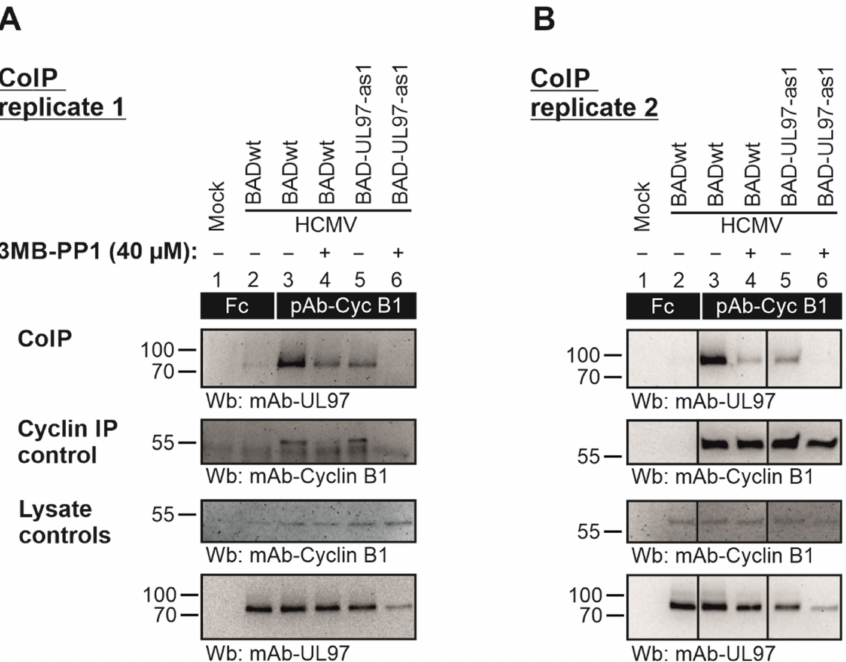
Figure 7. HFFs were cultivated in T175 flasks and used for infection with parental HCMV BADwt or recombinant BAD-UL97-as1 at a MOI of 0.5 for 4 d. An optional treatment with 40 µ M of 3MB-PP1 (+, 3MB-PP1; − , DMSO solvent controls) was performed starting 4 h prior to sample collection and again during cell lysis. Total cell lysates were prepared and used for cyclin B1-specific CoIP with the indicated antibodies (see black boxes; Fc fragment was used as a negative control) under the continuous presence of 3MB. ( A , B ) show two independently produced biological replicates of this CoIP experiment, in order to illustrate the range of variability of individual signal strengths of detected protein bands. The CoIP samples were subjected to SDS-PAGE/Wb analysis (CoIP) and additional control stainings were performed to verify successful immunoprecipitation (cyclin IP control) and protein expression levels (lysate